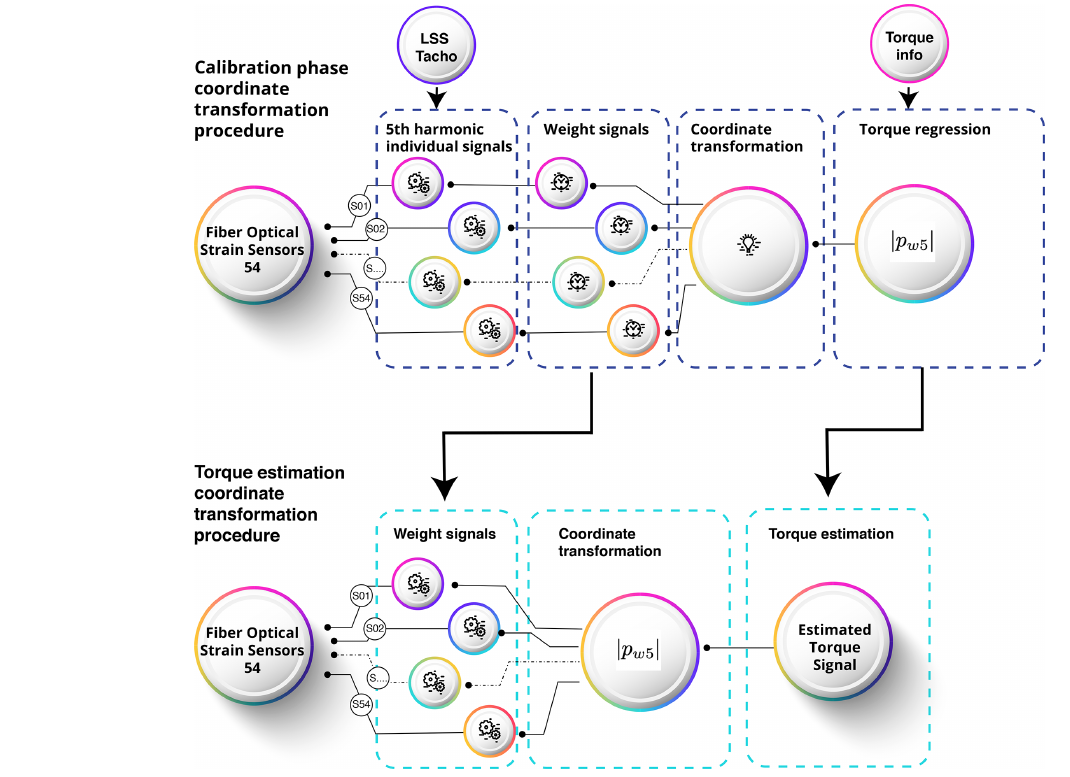
Figure 18. Torque estimation procedure based on a coordinate transformation.